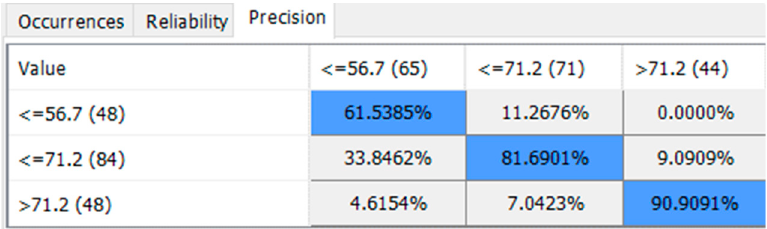
Figure 10. Confusion matrix of precision.